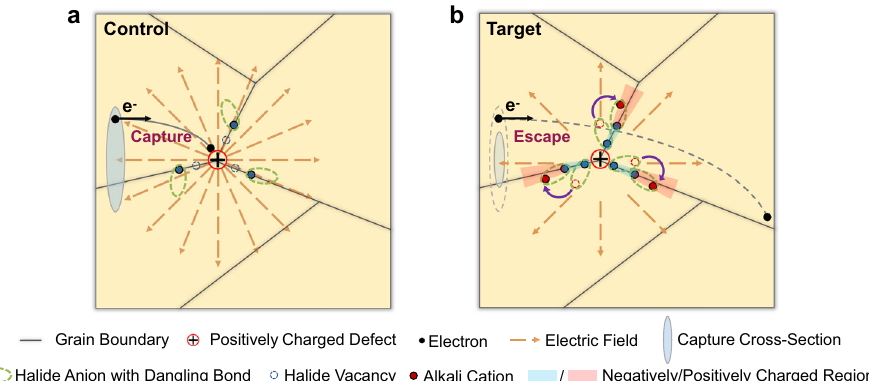
Fig. 2 Carrier capture event by charged defects. a , b Schematic diagram of the defect capture process in the control ( a ) and target ( b ) perovskite fi lms. Here we only show the process related to electrons for simplicity, and the same principle is also applicable to